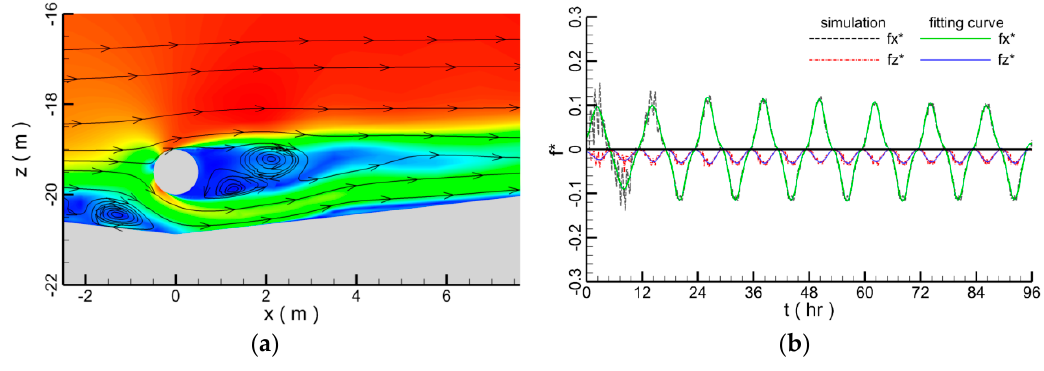
Figure 25. The simulation results with h = 0.25 m in time of t = 39 h. ( a ) Flow field. ( b ) Hydrodynamic force.